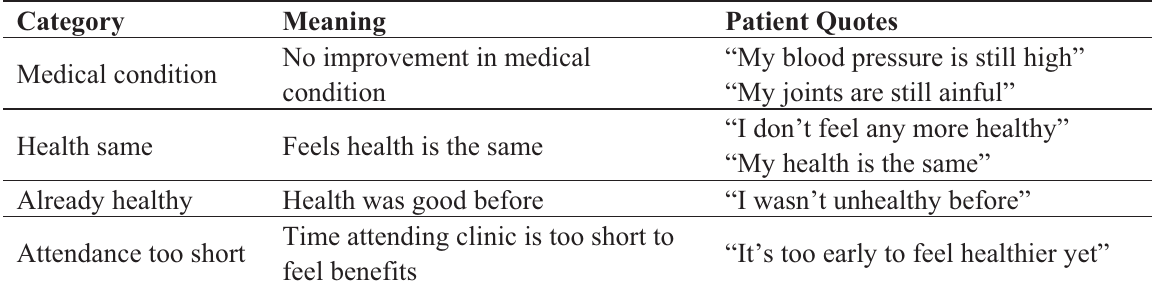
Table 15. Explanation of reasons given by patients for feeling their health had not improved. Category Meaning Patient